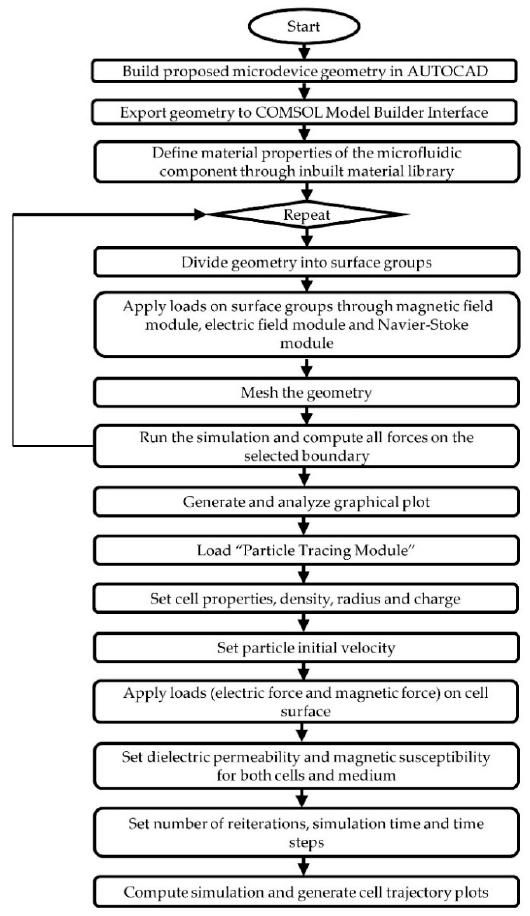
Figure 1. Detailed flow chart of our simulation approach.